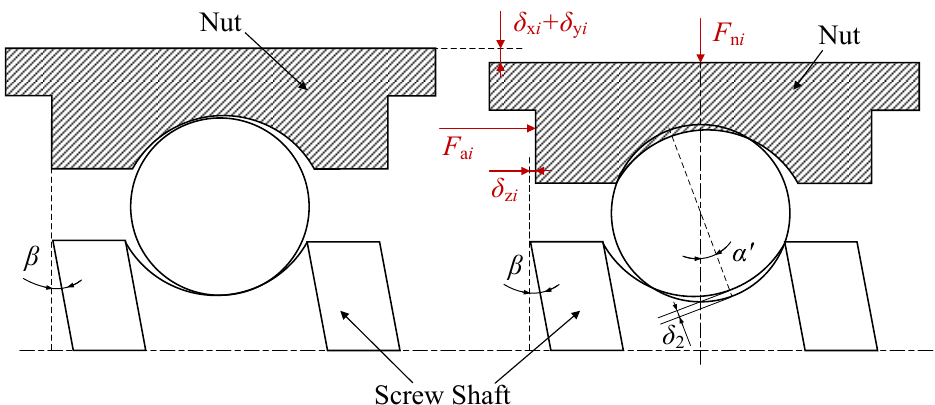
Figure 5. Change in nut displacements after the i th ball bears the load.